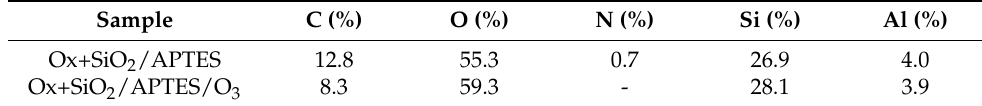
Table 1. Atomic concentration percentages of the elements found on samples surfaces *.